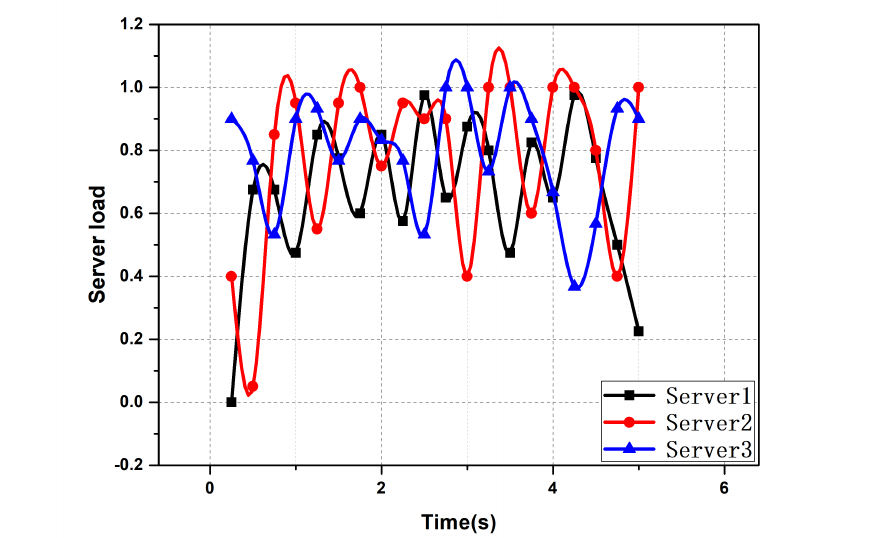
Figure 8. The fluctuation of the server load in the case of server selection based on the improved AHP